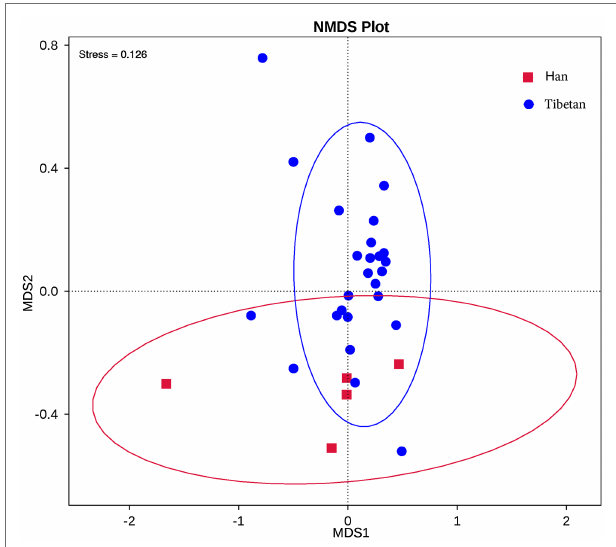
FIGURE 2 | Nonmetric multidimensional scaling (NMDS) showed distinct fecal bacterial communities in the native Tibetans and Han immigrants. Each symbol represents the fecal microbiota of one sample. NMDS plots were derived from the Bray–Curtis distances between the